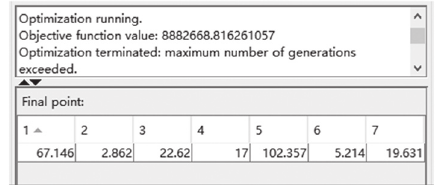
Figure 7: Optimization results of genetic